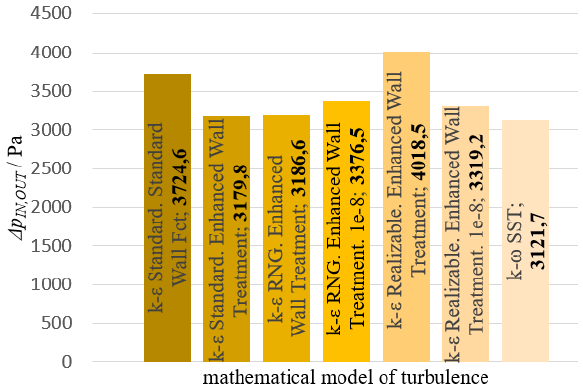
Fig. 3. Comparison of mathematical models of turbulence